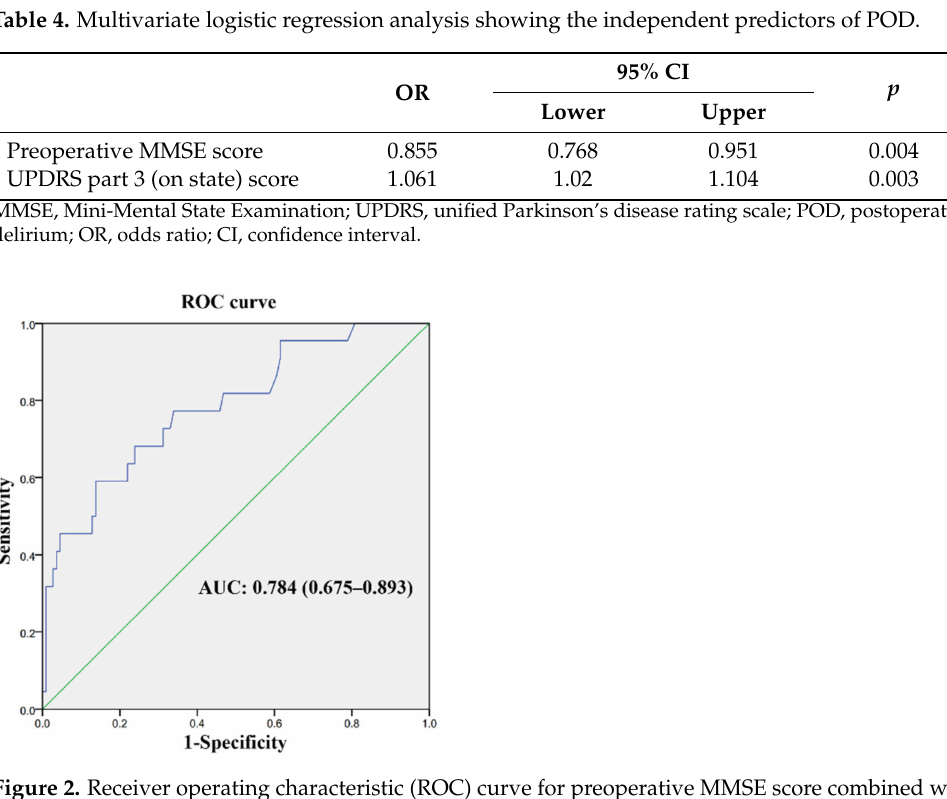
Figure 2. Receiver operating characteristic (ROC) curve for preoperative MMSE score combined with UPDRS part 3 (on state) score as a predictor of